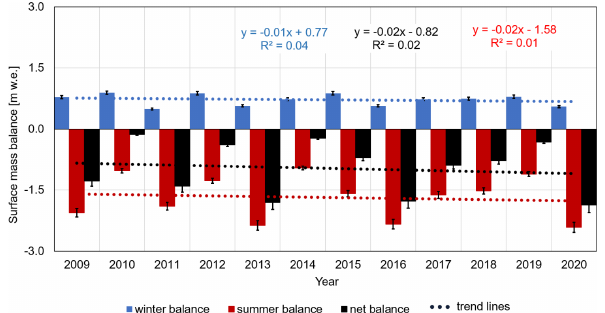
Figure 6. Annual surface mass balance and its components of Werenskioldbreen during 2009–2020. Blue bars: winter mass bal- ance; red bars: summer mass balance; black bars: net mass balance. The results for 2019 may be understated (i.e. field measurements were performed by a non-expert